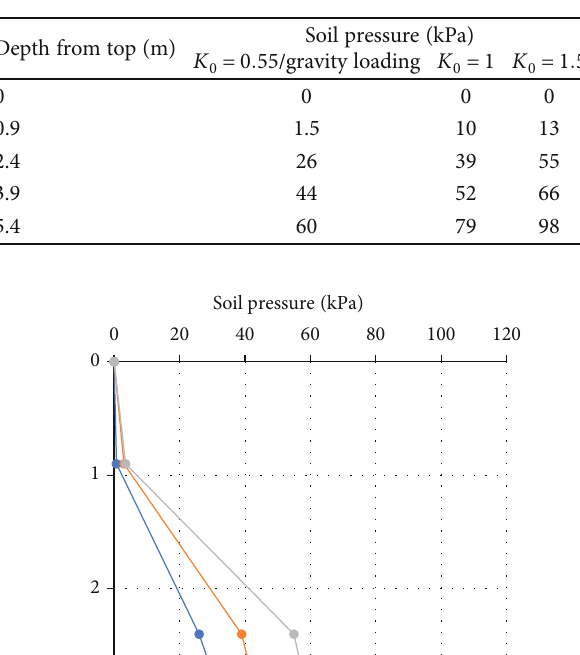
Table 9: Soil pressure at di ff erent depths of the excavation by the PLAXIS-3D MC model with di ff erent K